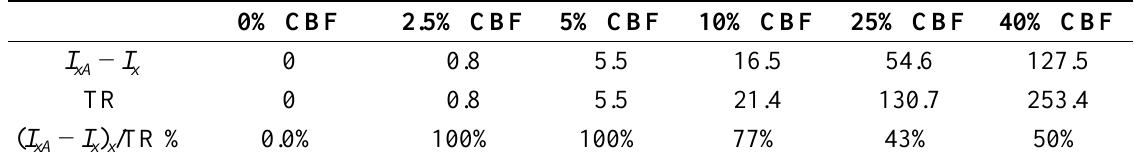
Table 5. Maximum penetration into therapeutic regions for six CBF levels when injury courses are run at S = 0